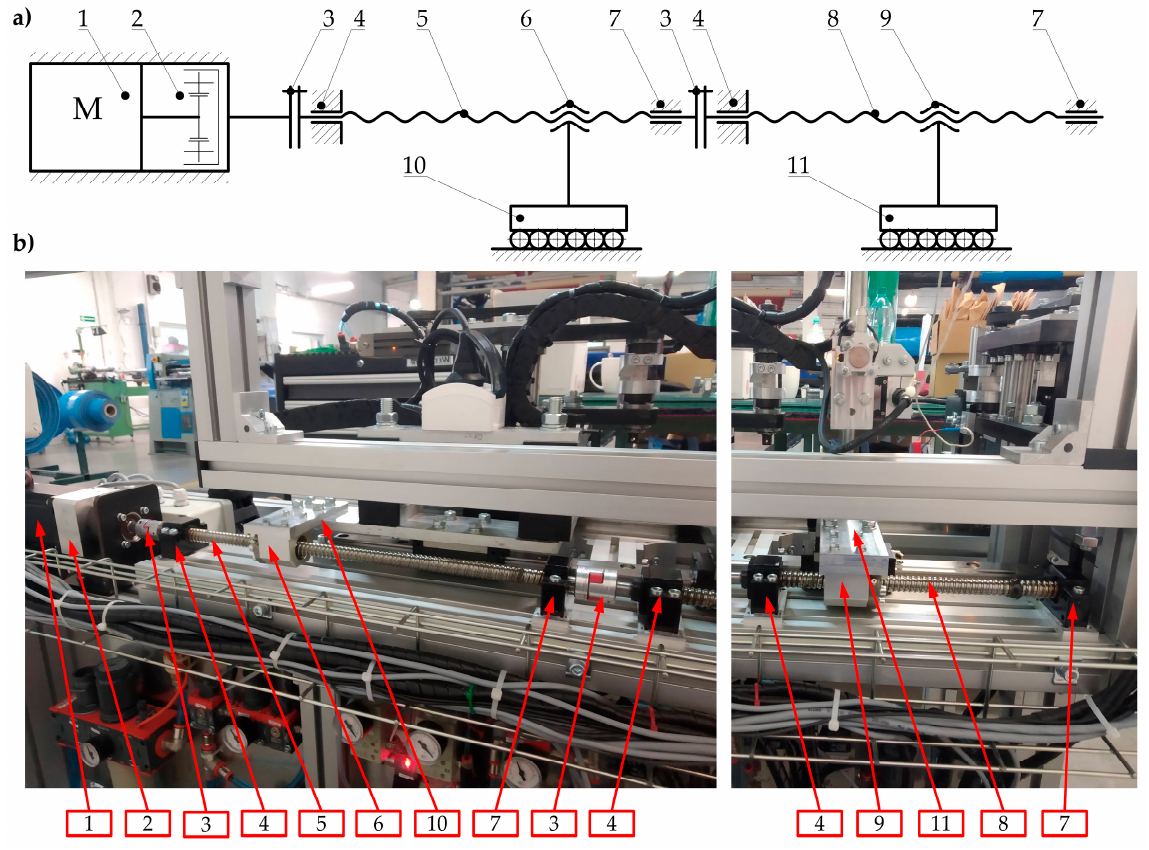
Figure 6. The main drive system of the automatic welding machine: ( a ) kinematic structure of the drive mechanism, ( b ) practical implementation of designed drive unit in manufactured ma- chine;1BLDC electric motor, 2—planetary gear, 3—jaw coupling with flexible insert, 4—angular bearing unit (fixing), 5—ball screw with pitch p 1 , 6—ball nut with pitch p 1 , 7—radial bearing unit (floating), 8—ball screw with pitch p 2 , 9—ball nut with pitch p 2 , 10—movable belt holder assembly, 11—heating unit assembly.